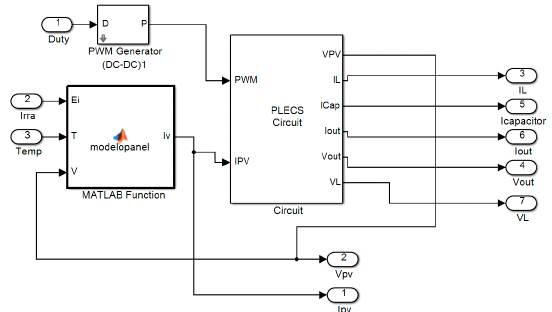
Figure 5. PV module and buck converter.